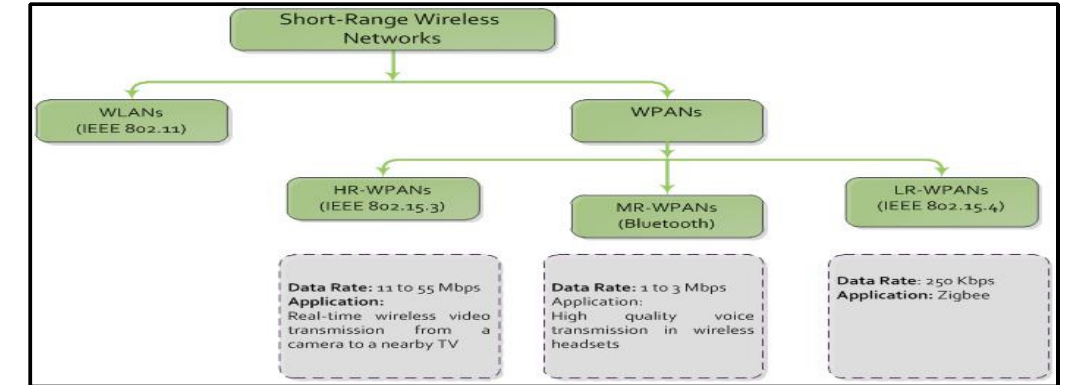
Fig. 1. Classes of Short-Range Wireless Network.